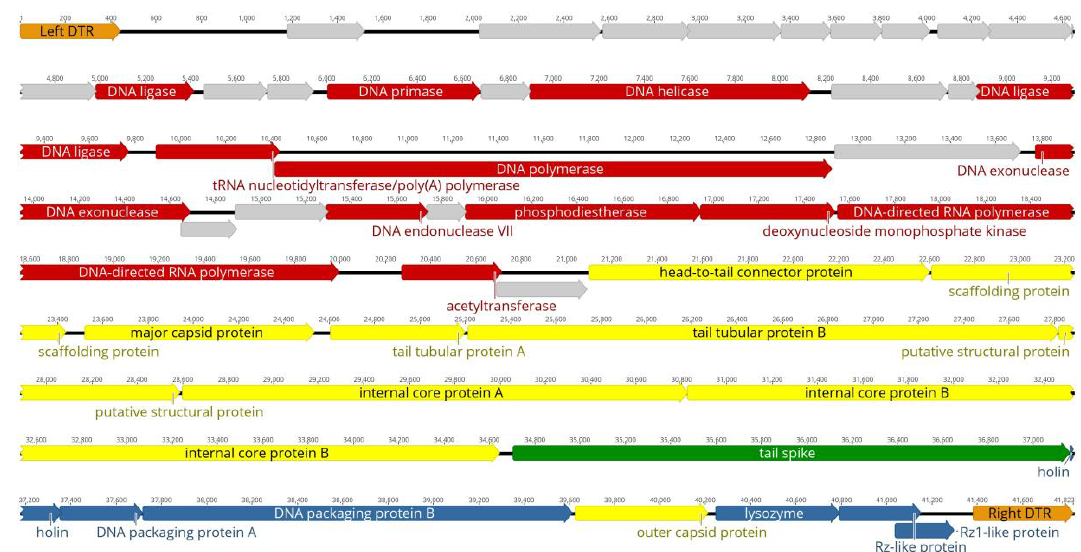
Figure 3. Genetic map of phage Arno 160. Nucleic acid metabolism, replication and transcription genes are colored in red, structural genes in yellow, adsorption apparatus genes in green, lysis genes in blue. Hypothetical protein genes are colored in grey.